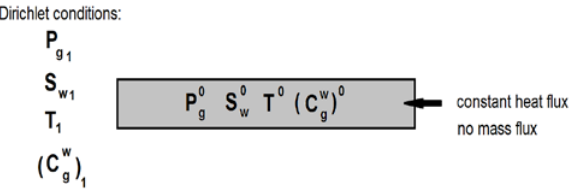
Fig. 1. The heat pipe problem